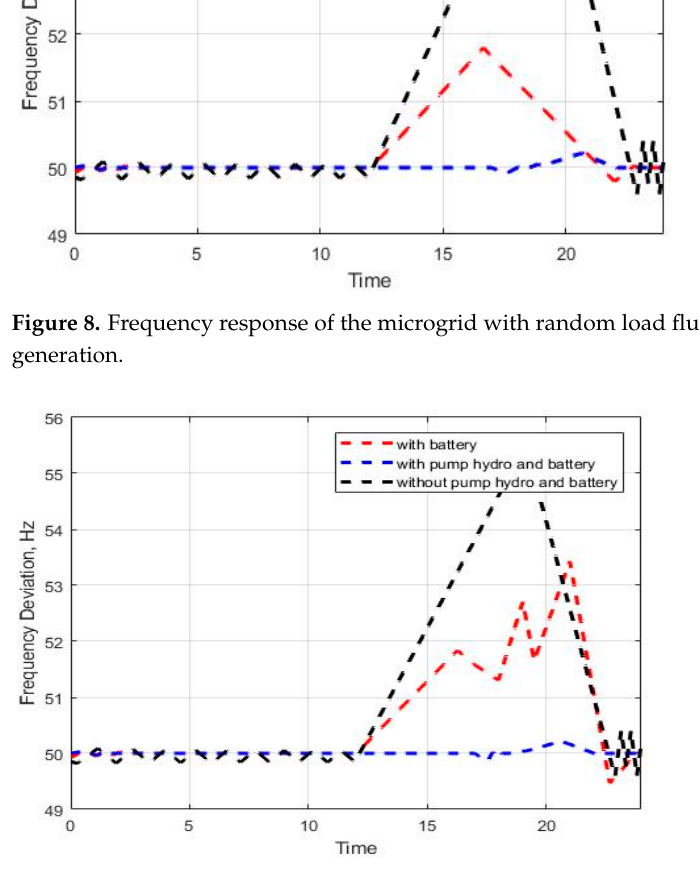
Figure 10. Power response of the microgrid with storage system without full-day solar power.